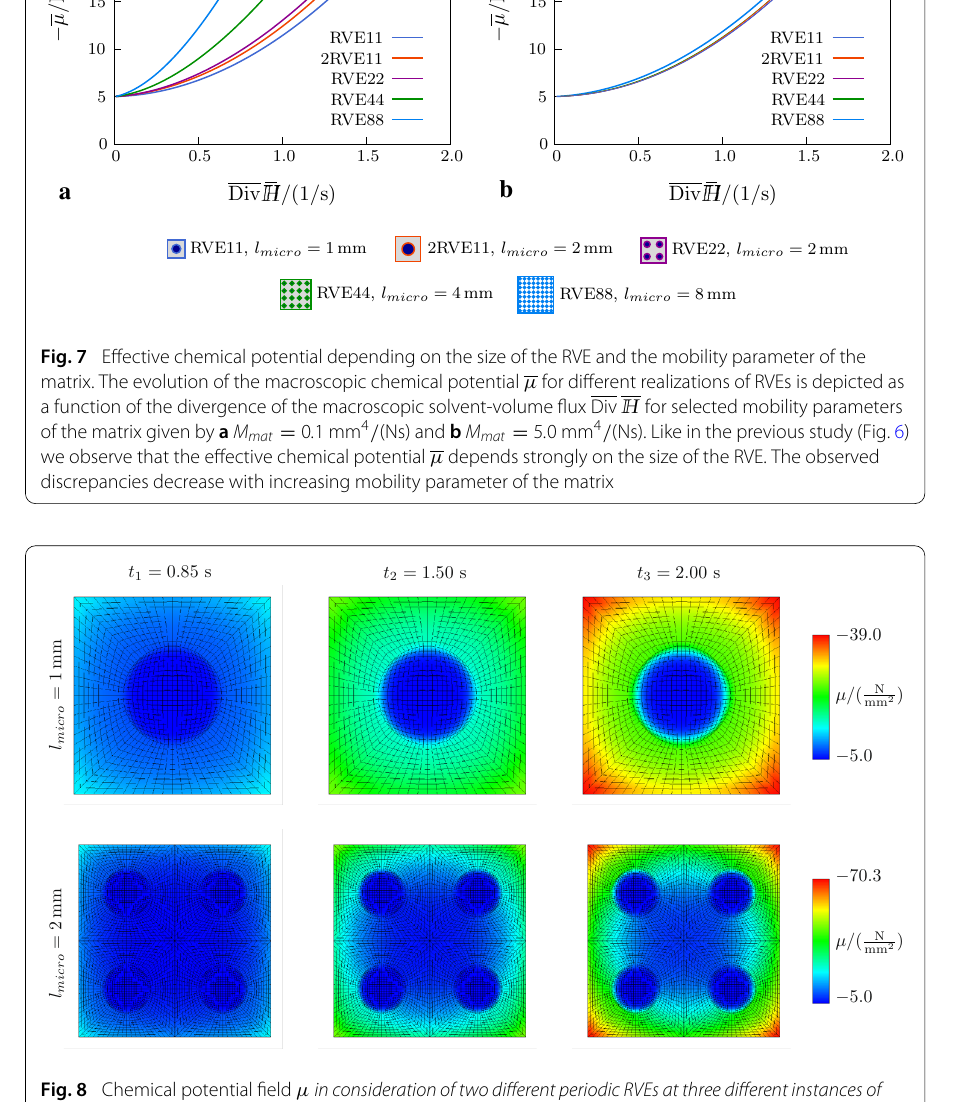
(cid:5) H → 0 the solvent such that finally and thus μ size → 0. In the stationary state, the size- independent term of the macroscopic chemical potential (37) is identical for all considered RVEs since we assume the same chemical parameters for both phases in the microscopic chemical energy